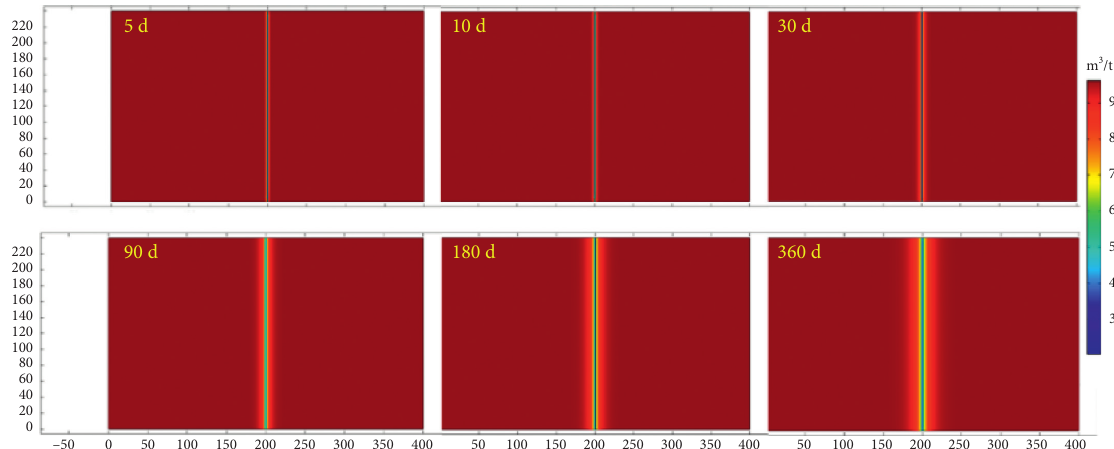
Figure 15: Cloud map of coal seam gas content under different drainage time of 240-meter borehole.